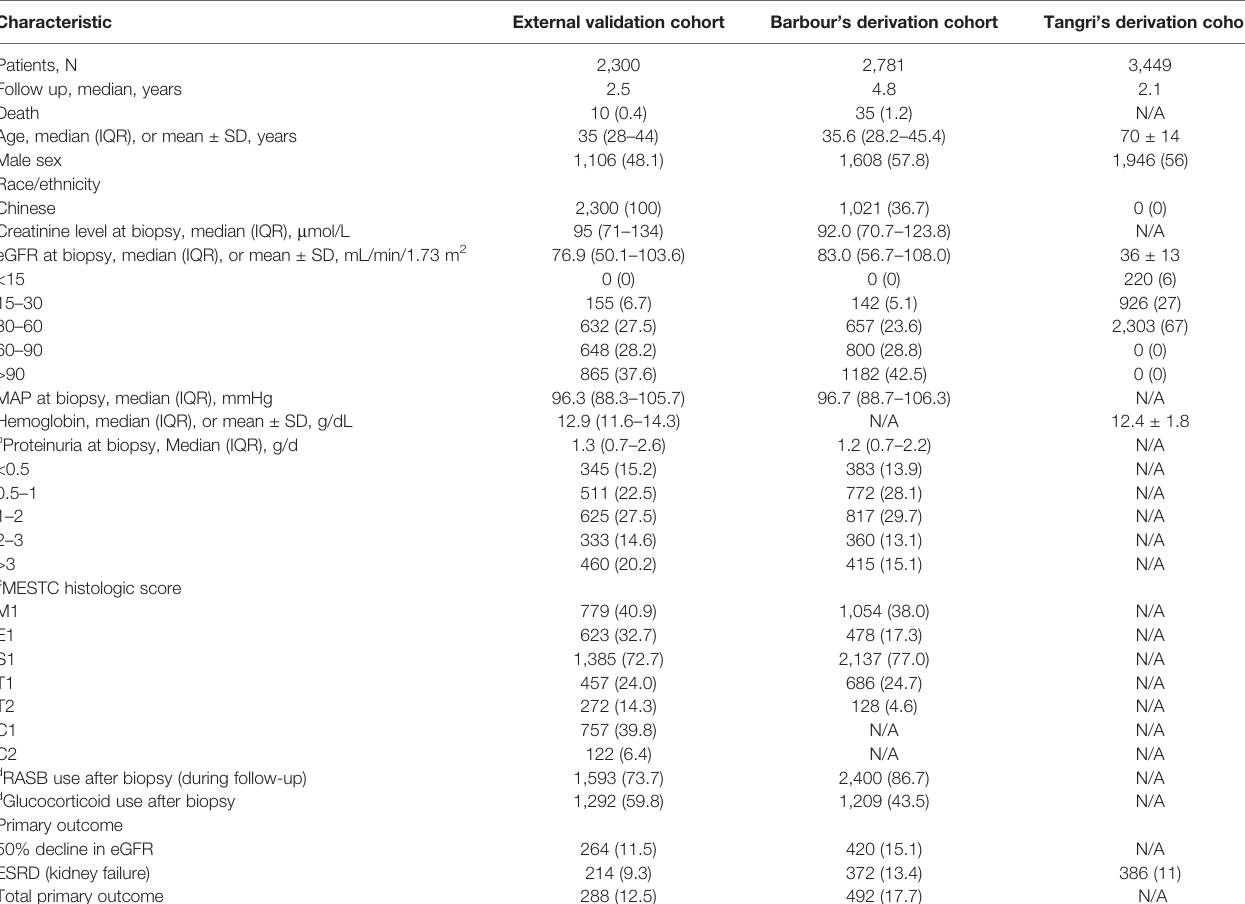
TABLE 1 | Characteristics of patients in our external validation cohort, Barbour ’ s derivation cohort, and Tangri ’ s derivation cohort. a